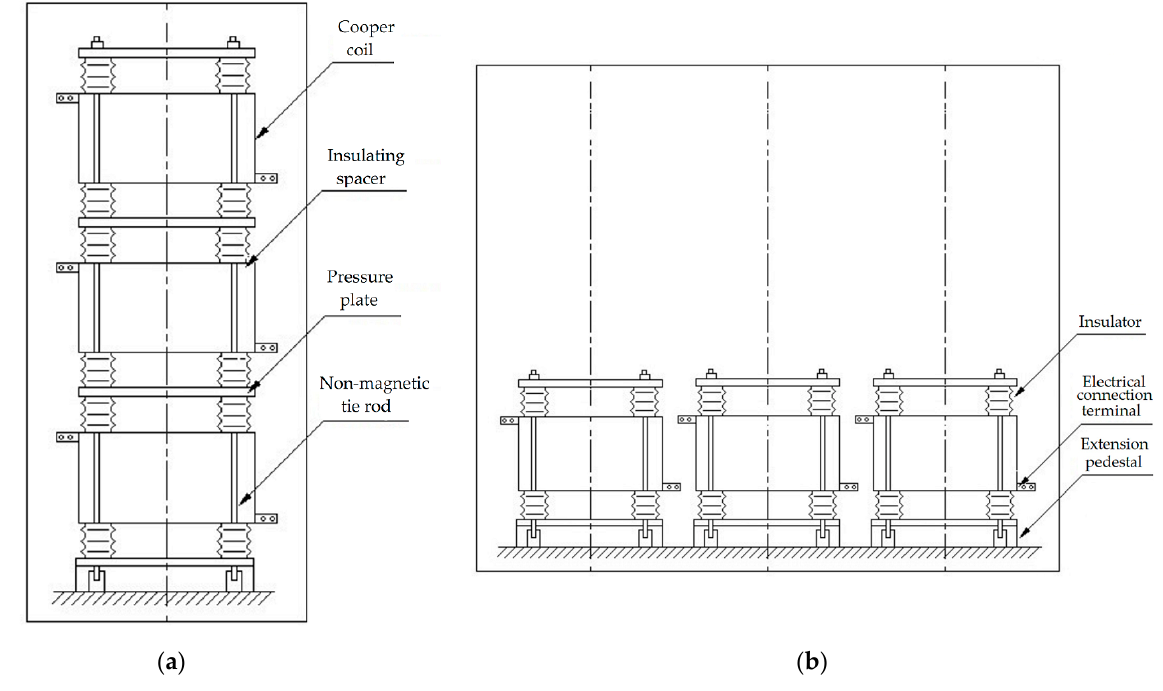
Figure 1. A typical solution for a three-phase unit of air-core current-limiting reactors for an MV industrial grid with non-magnetic shielding placed: ( a ) coaxially with provision for bracing against the compartment wall (stacked); ( b ) parallel with braces between phases.